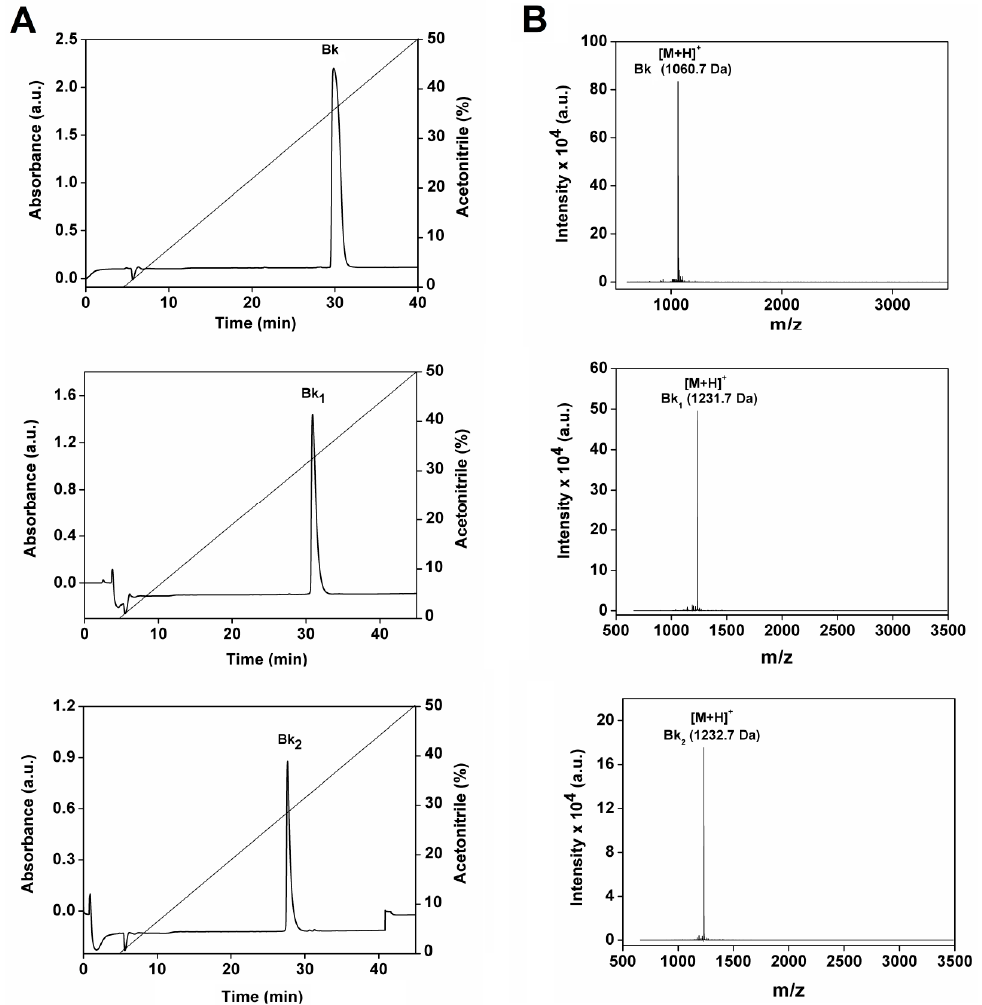
Figure 1. Purification of the synthetic peptides Bk, Bk 1 and Bk 2 . ( A ) Reverse-phase chromatography C 18 Vydac 218 TP 510 column using a linear gradient (5%–95%) of